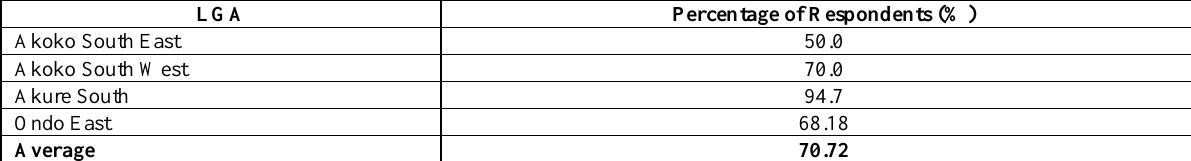
Table 5. Percentage of Households that spend less on Electricity Consumption with introduction of Paid Meters